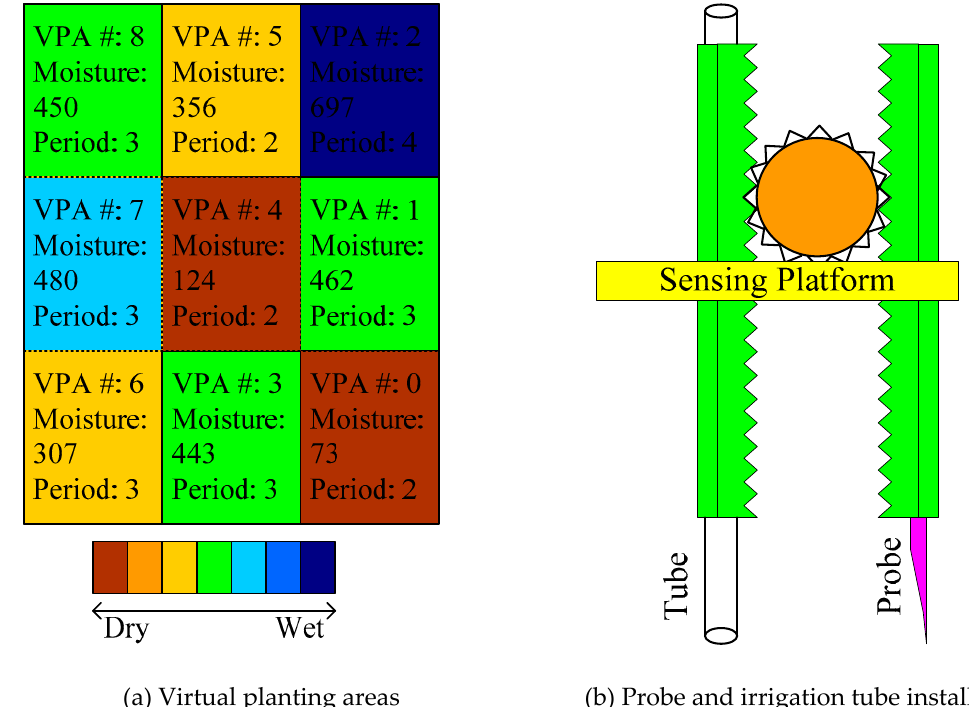
Figure 1. The system architecture of Constant-moisture Automatic Irrigation System (CAIS). CAIS contains Core Decision Unit (CDU) and Sensing and Irrigation Unit (SIU). The CDU is responsible for analyzing and forecasting the soil moisture and the SIU is responsible for sampling the soil moisture and controls the watering system.